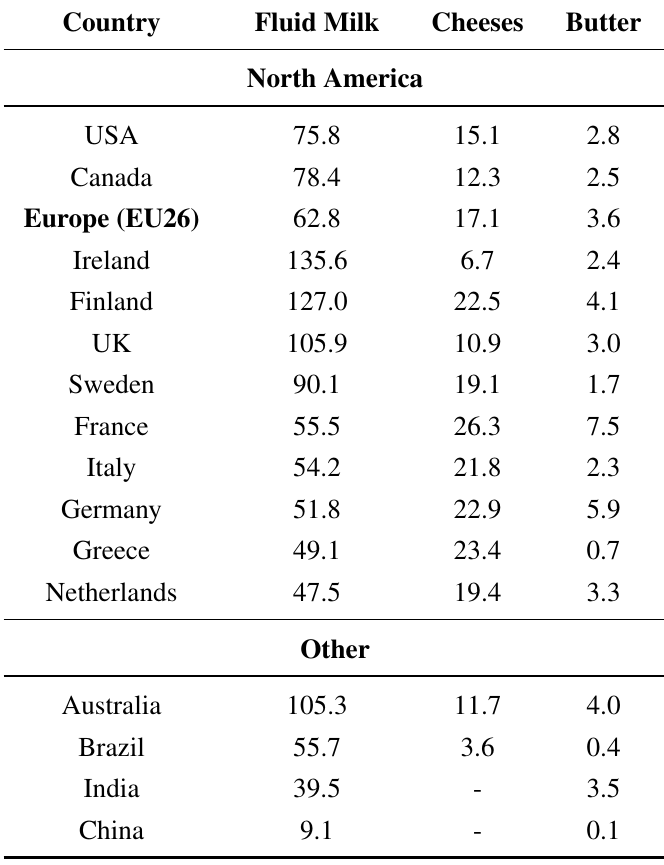
Table 4. Per capita consumption of milk (L) and milk products (kg) in various countries–2011